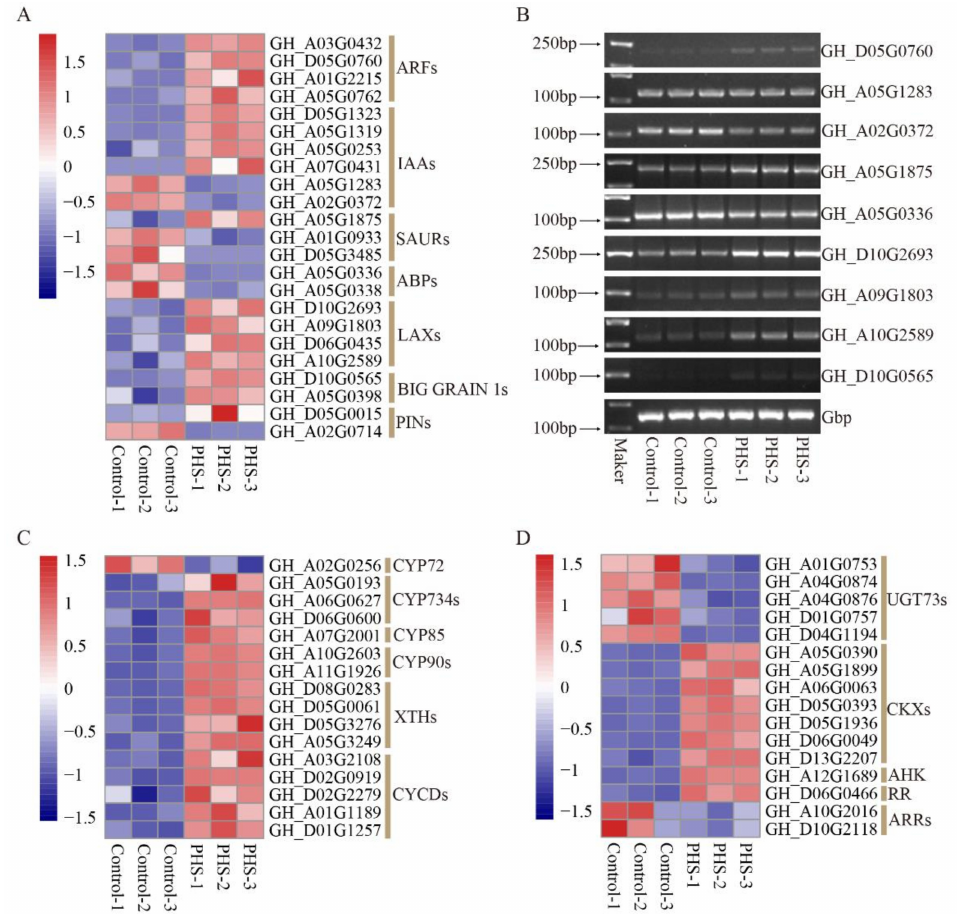
Figure 8. Involvement of differentially expressed genes (DEGs) related to plant hormones in PHS (t18:0, phytosphingosine)-related promotion of embryo growth. ( A ) Heat map of auxin signaling pathway gene expression in the control and PHS-treated samples after culture for 10 days. ( B ) Semi- quantitative PCR of auxin signaling pathway genes in the same control and PHS samples. DL2000 DNA marker (left). Amplified genes of interest (right). ( C , D ) Heat map of brassinosteroid ( C ) and zeatin ( D ) biosynthesis and signal transduction pathway gene expression in the control and PHS-treated samples after culture for 10